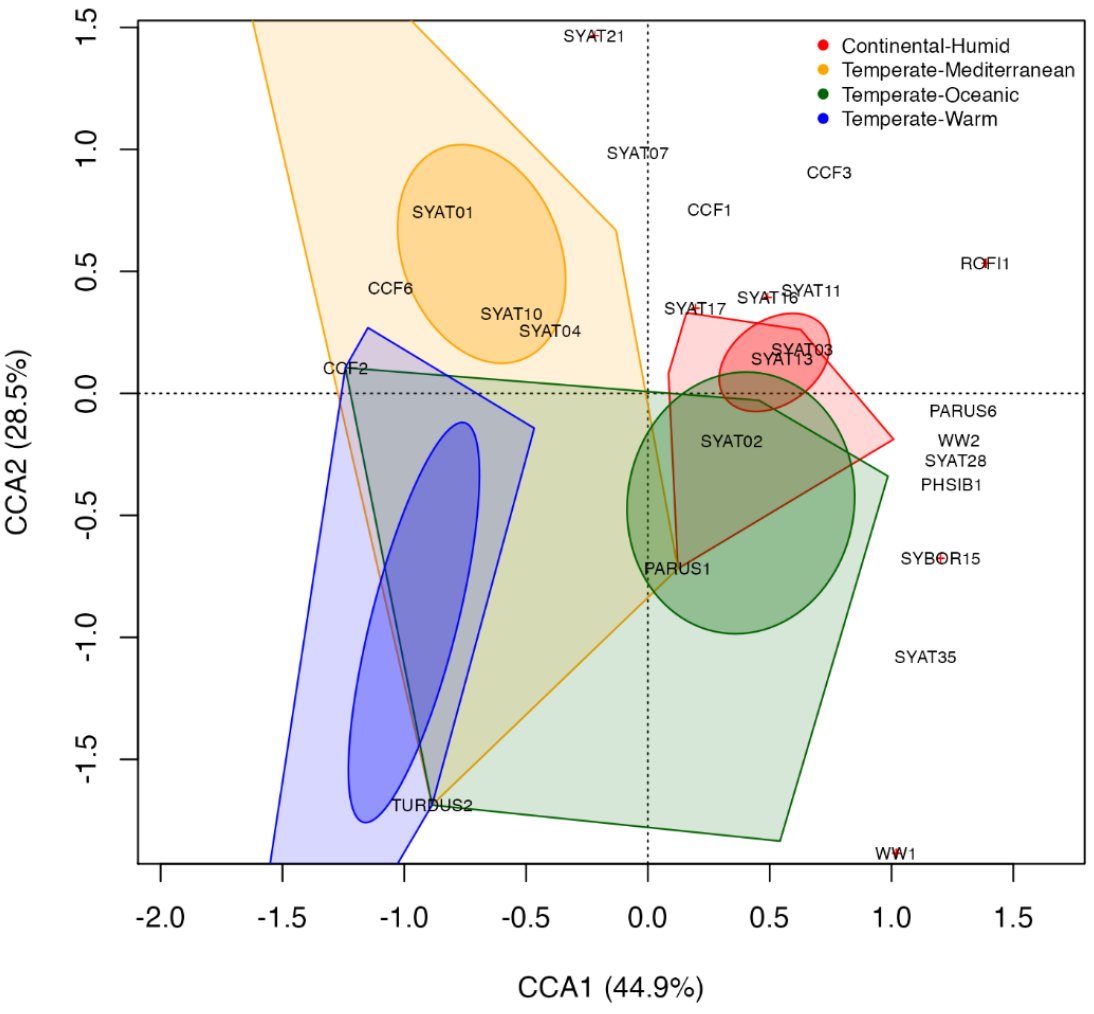
Figure 5. Constrained canonical analysis biplot of haemoproteid presence data for five widespread European avian hosts at 68 sites in the Western Palearctic. Haemoproteid presence data is constrained by a categorical environmental variable—climate type. The scaling 1 biplot shows ellipses representing 95% confidence intervals around each climate’s centroid and polygons representing the area created by connecting the outermost site scores for each climate. Red crosses show locations with overlapping lineages, in which cases the relatively most abundant lineage is shown (see Table S3 for CCA lineage scores).